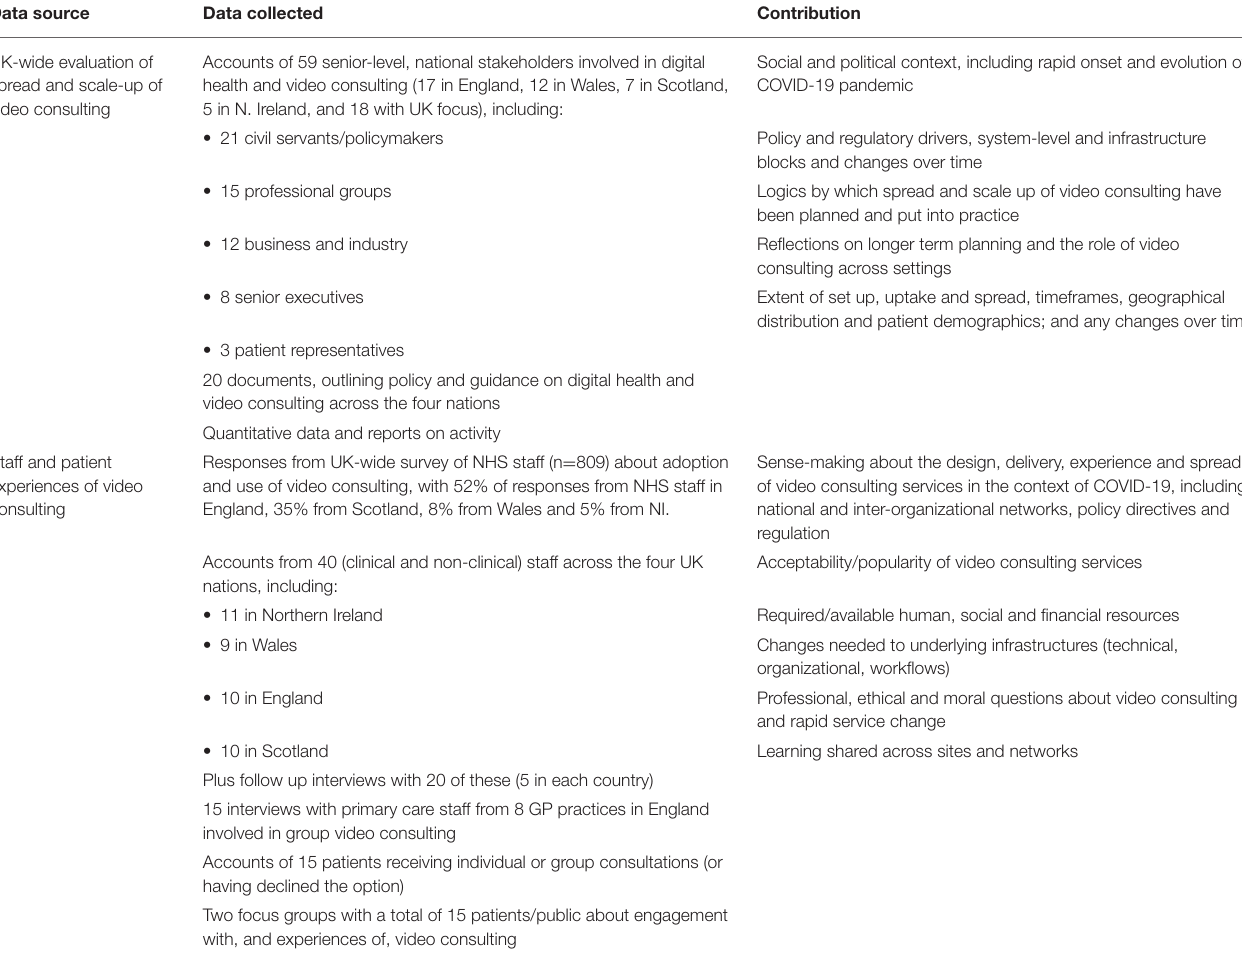
TABLE 2 | Overview of data sources and analysis. Data